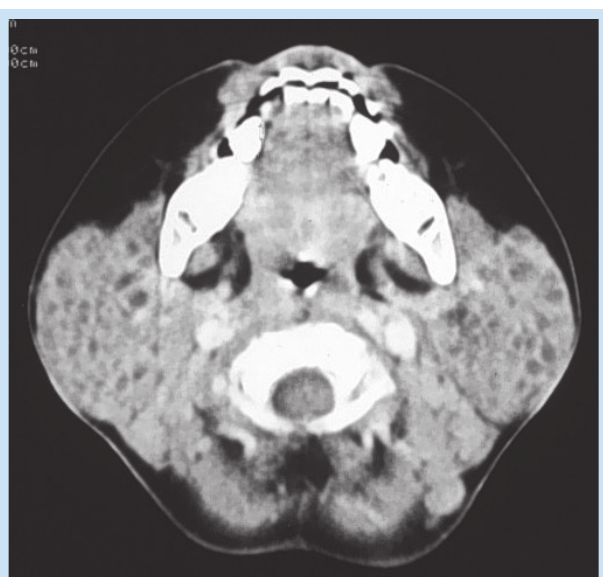
Fig. 2. Axial CT (post contrast): Enlarged bilateral parotid glands with multi- ple small cysts and posterior cervical lymphadenopathy.